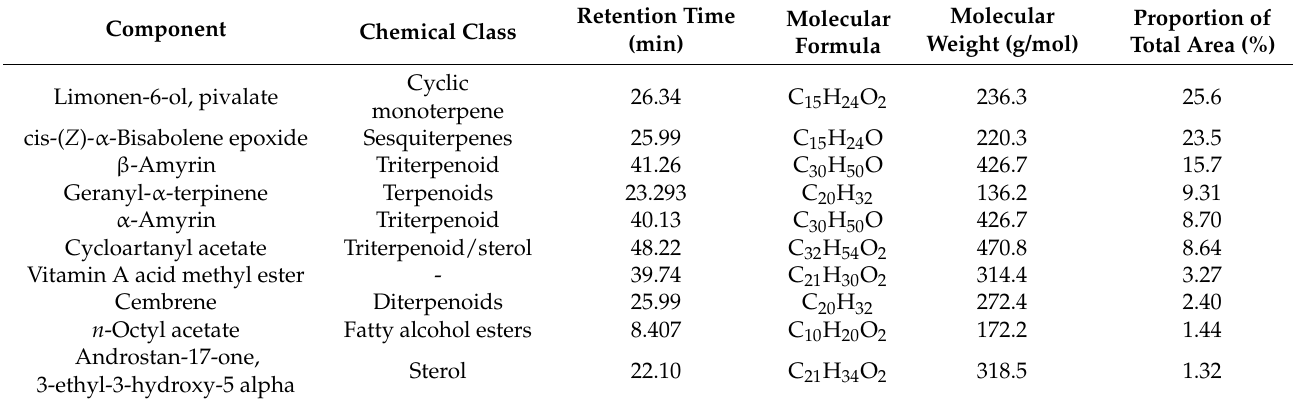
Table 1. Gas chromatographic–mass spectral analysis of the bioactive components of Boswellia sacra Flueck.